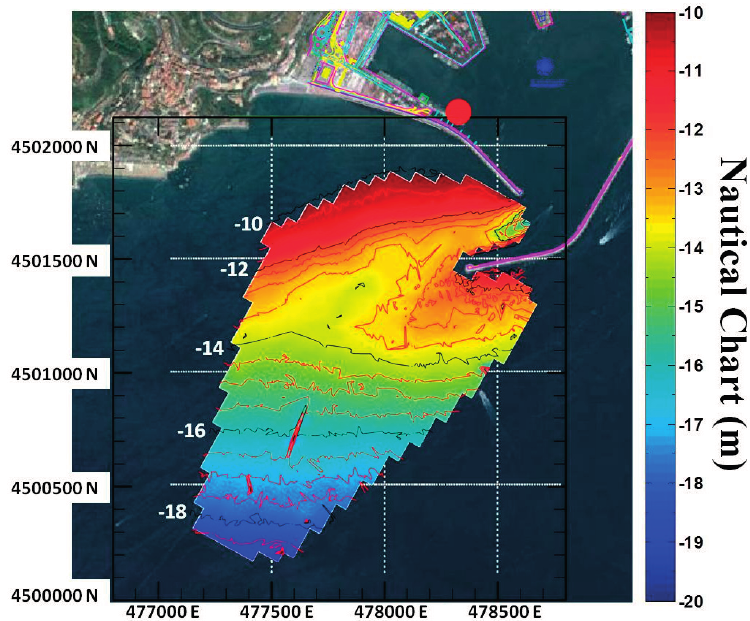
Figure 6. Echo-sounder bathymetry map. The red circle denotes the radar location.